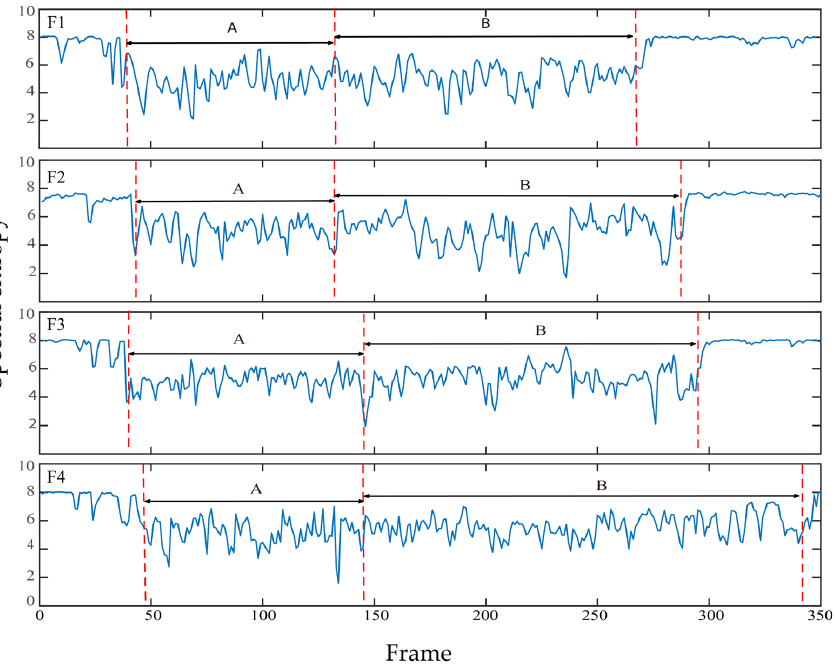
Figure 6. Spectrum entropy of largemouth bass feeding signal under different breeding densities (A is the ingestion stage; B is the chewing stage): F1 represents the experimental group of breeding density of 4; F2 represents the experimental group of breeding density of 8; F3 represents the experimental group of breeding density of 12; F4 represents the experimental group of breeding density of 16).